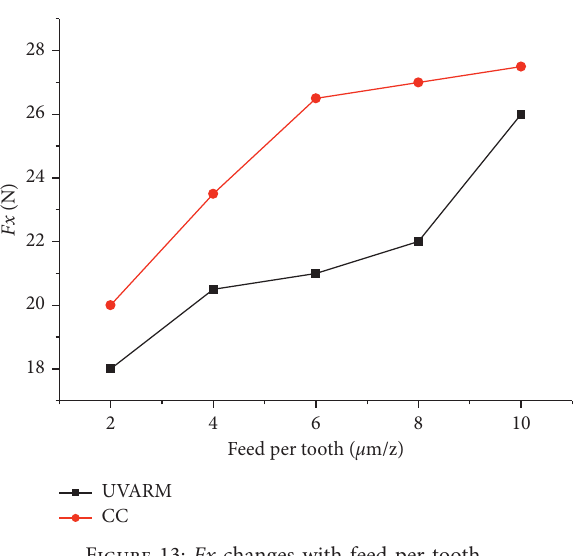
Figure 15: Fz changes with feed per tooth.